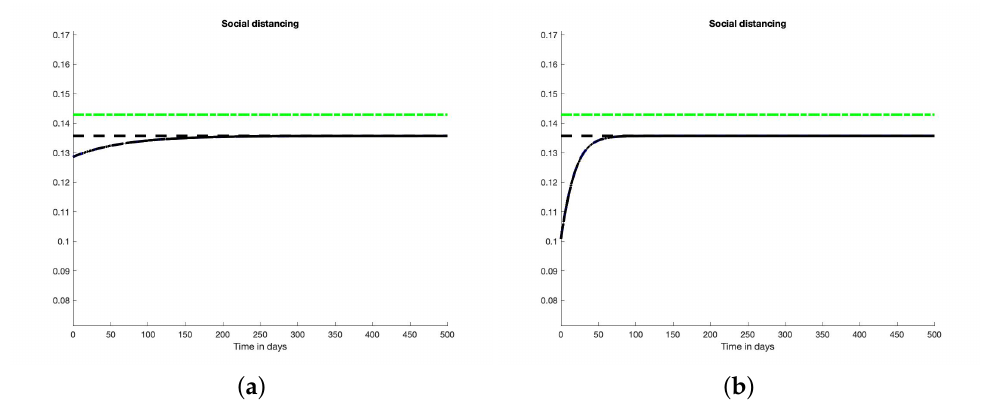
Figure 1. Scenario 1: Open-loop control. ( a ) 35 days later: β , β ∗ (- -, blue), γ (- ., green) and β acceptable